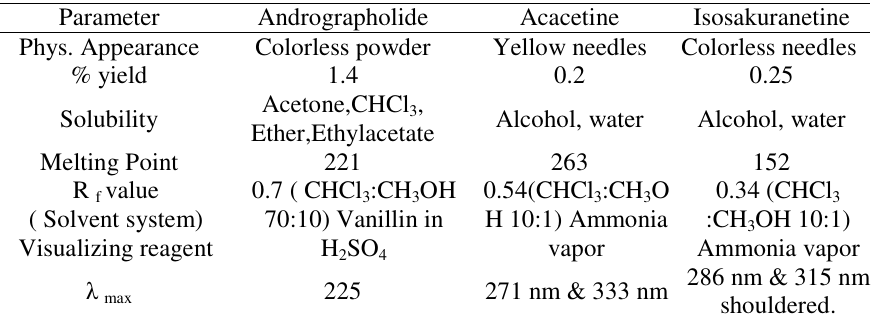
Table 2. Physicochemical data of isolated